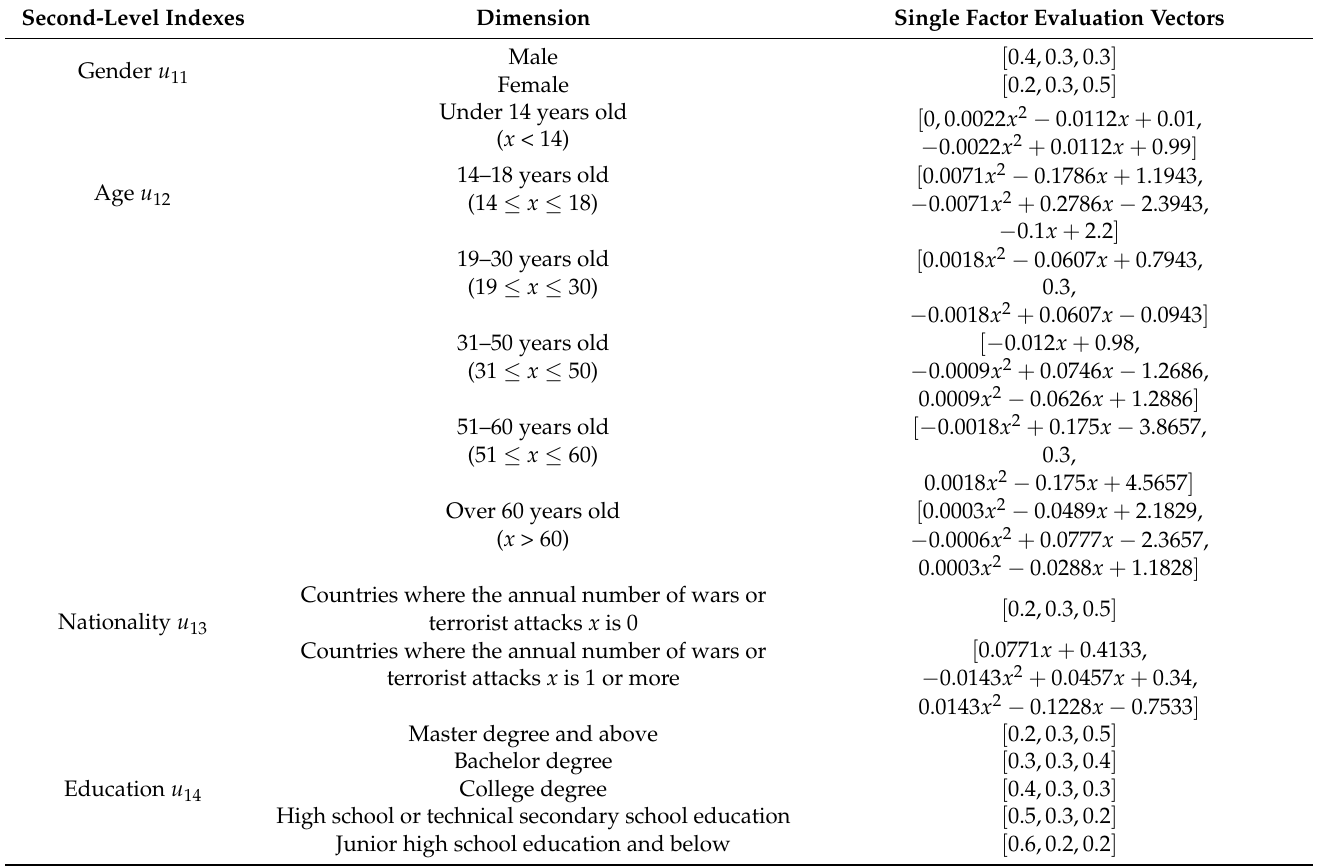
Table 9. Single factor evaluation of basic background indexes.